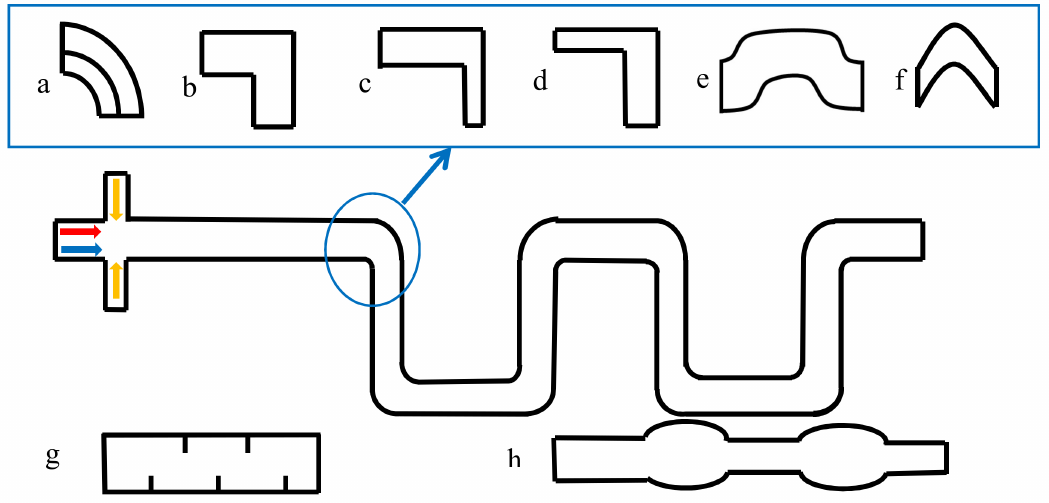
Figure 4. Deforming microchannels, ( a –f) different structures of the meandering microchannel, ( g ) obstacle arrangements inside a microchannel, ( h ) the structure of a deforming